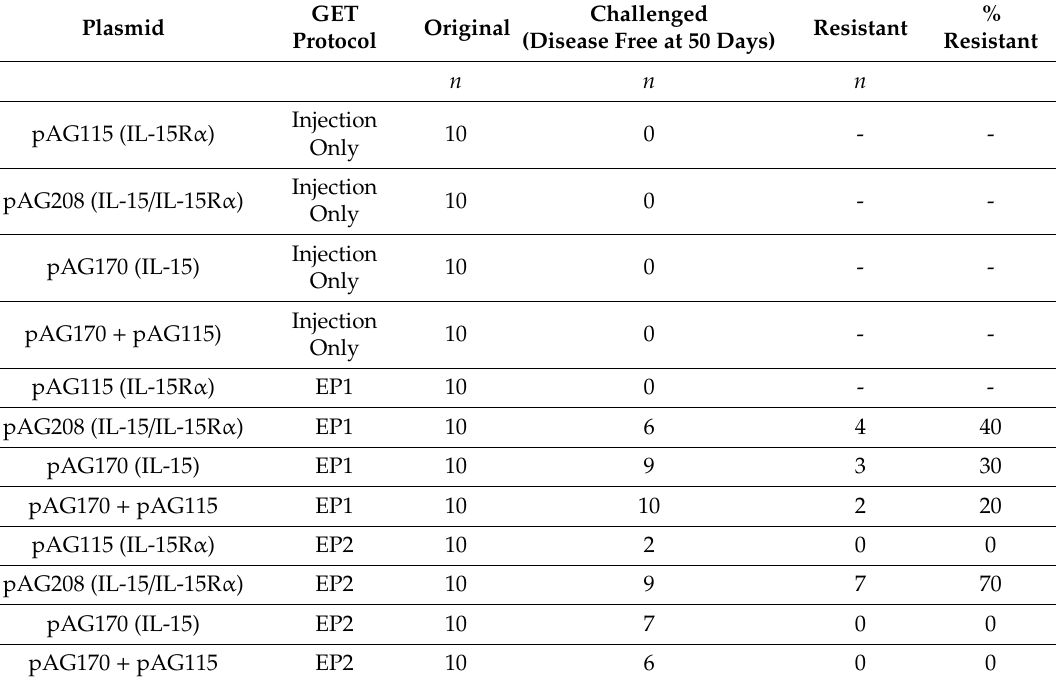
Table 1. Long term survival of mice that received gene